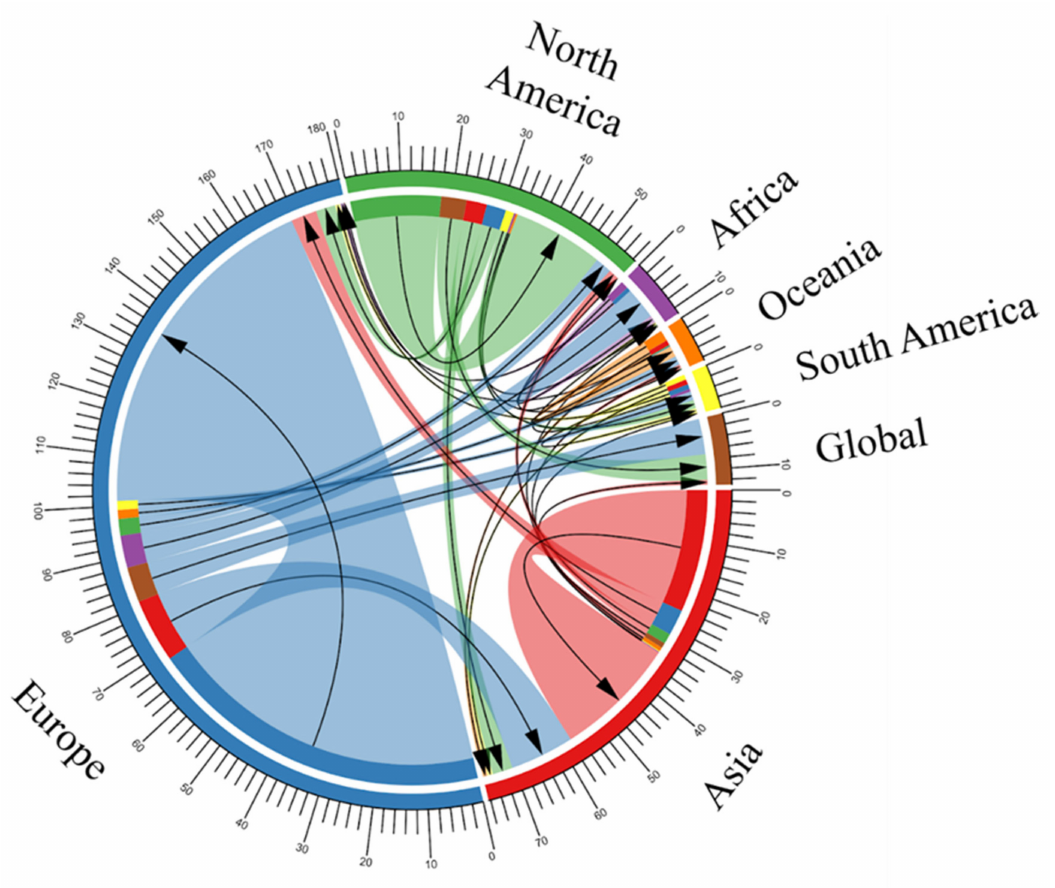
Figure 3. Graphical representation of the number of OSM-related papers based on the continents of authors’ affiliations and the continents of study areas. Arrows indicate a flow from the affiliation continent to the case study continent. The radial axis indicates the number of